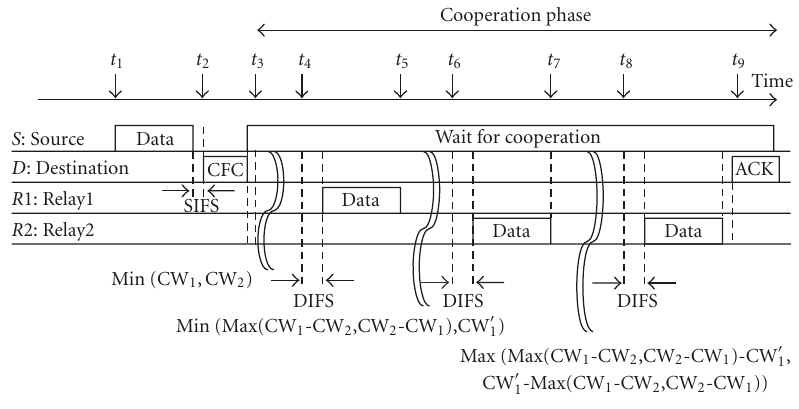
Figure 4: PRCSMA example of